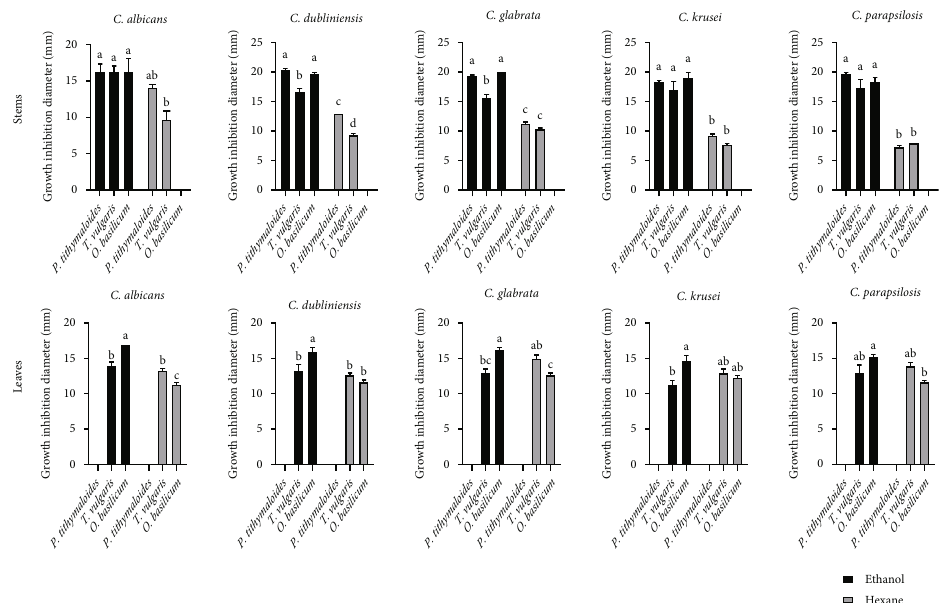
Figure 3: Diameters of the inhibition halos of the P. tithymaloides , T. vulgaris , and O. basilicum extracts from stems and leaves (horizontal layout) against the fi ve Candida species at an OD 0.5 (vertical layout). Black and dark gray bars represent ethanolic and hexanoic 600nm extracts, respectively. Di ff erent letters indicate signi fi cant di ff erences between treatments (Tukey ’ s test p ≤ 0 : 05 ). Error bars indicate the standard error of the mean (SEM, n = 3